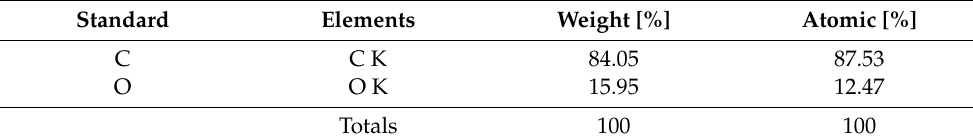
Figure 6. ( a ) Morphology of the carbon thin film, ( b ) particles precipitated in the thickness of the carbon film. Table 2. Spectrum